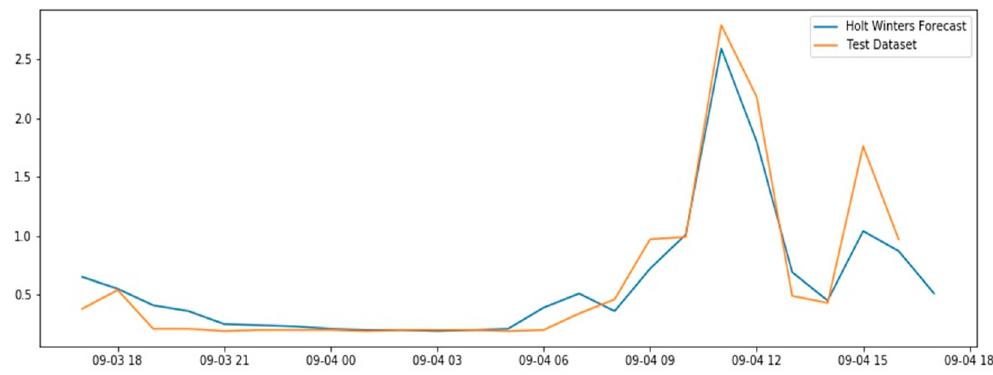
Figure 6. Comparison between real values and Holt–Winters forecasting based on a 24 h period.